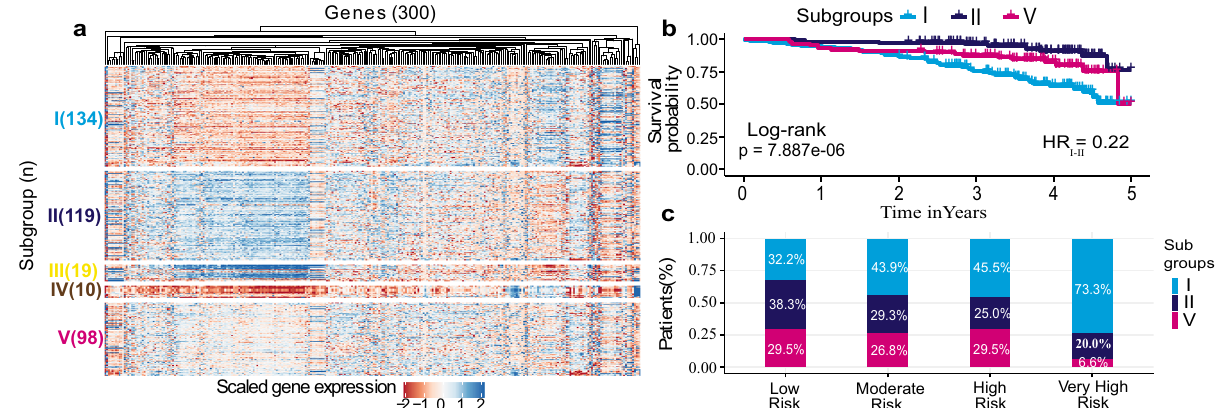
Fig. 2 Gene expression pro fi les, survival and risk categories that demonstrate fi ve distinct subgroups. a The expression heatmap for the fi ve discovered subgroups showing distinct expression pro fi les. b Kaplan – Meier survival curves for the three predominant subgroups demonstrating the difference in survival pro fi les (from RNA sampling) for a span of 5 years along with two-sided log-rank test p values. c The percentage of predominant subgroups I, II and V patients across REVEAL risk categories. High- and very-high-risk populations mostly consist of subgroup I patients (45.5% and 73.3%, respectively), while the low-risk population is mostly composed of subgroup II (38.3%) and V (29.5%) patients. Fisher ’ s exact test showed a statistically signi fi cant difference (two-sided p value = 0.024) between subgroups I and II for low- and very-high-risk